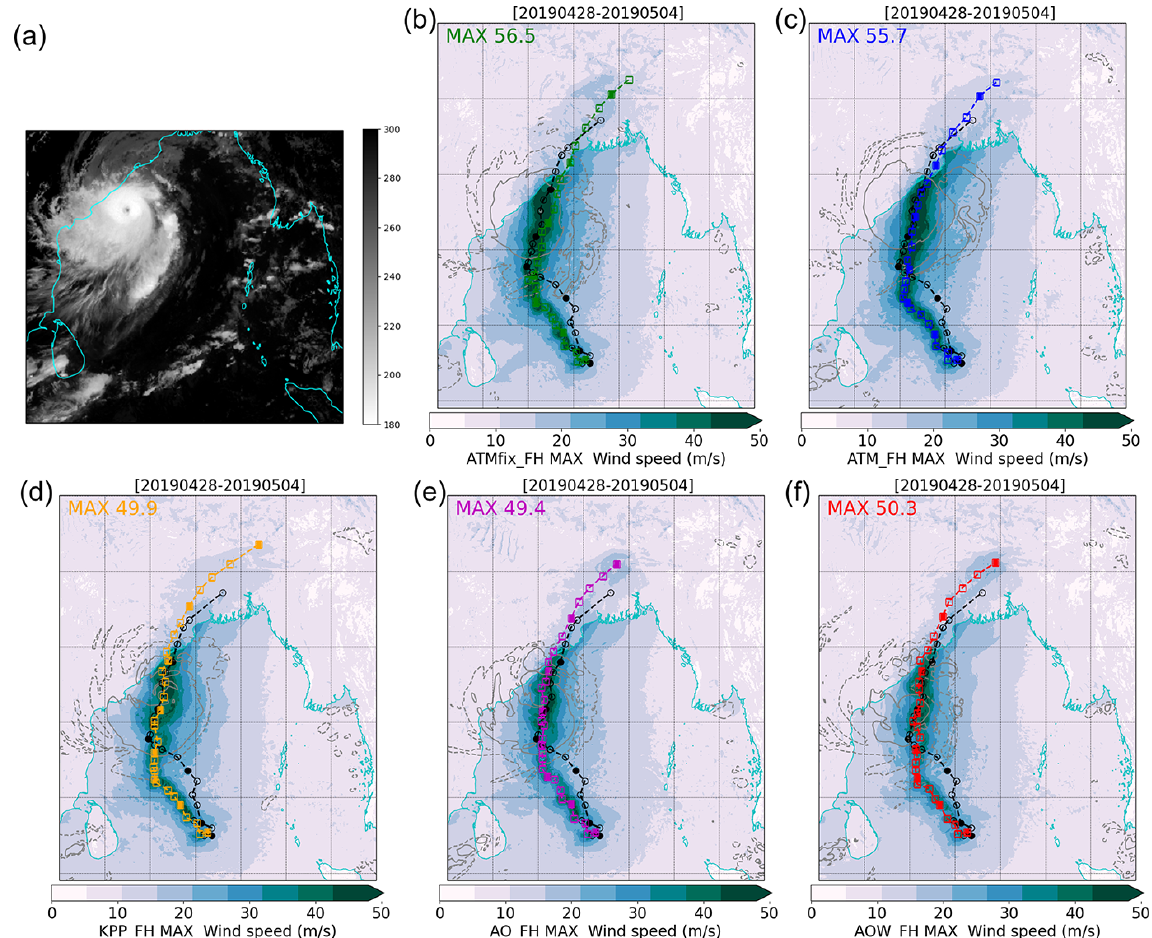
Figure 6. (a) Illustration of Cyclone Fani satellite-observed brightness temperature from INSAT at 06:00UTC on 2 May 2019. In (b) – (f) , results from RCS-IND1 experiments showing maximum wind speed during the 7d simulation (coloured shading). Also plotted is the diagnosed simulated cyclone track at 6-hourly intervals (coloured line and squares) compared with observed track at 6-hourly intervals (black line and circles). Line contours show instantaneous simulated outgoing longwave radiation at top of atmosphere (dashed line indicating 150Wm − 2 , solid line 100Wm − 2 contour) at coincident hour to the satellite observation in (a) . See Fig. S2 for corresponding figure for simulations without frictional heating